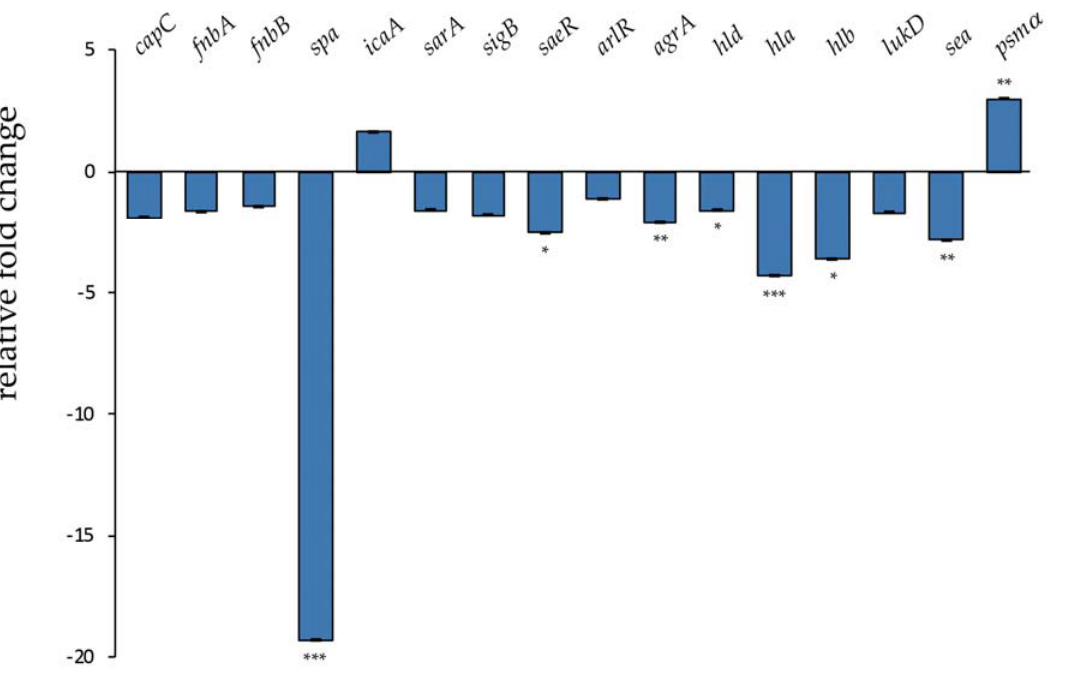
Figure 5. Transcriptional profiling of virulence factor genes in S. aureus ATCC 29213 after treatment with l ‐ NPDNJ determined by qRT ‐ PCR. Data were normalized to rpoB expression. Fold ‐ changes were calculated using treated versus untreated S. aureus cells. Asterisks indicate statistically significant differences between treated and untreated S. aureus cells (* p < 0.05, ** p < 0.01, *** p < 0.001). capC , capsule biosynthesis protein C; fnbA , fibronectin ‐ binding protein A; fnbB , fibronectin ‐ binding protein B; spa , surface protein A; icaA , intercellular adhesion protein A; sarA , staphylococcal accessory regulator A; sigB , RNA polymerase sigma factor B; saeR , response regulator SaeR; arlR , response regulator ArlR; agrA , accessory gene regulator A; hld , delta ‐ hemolysin; hla , alpha ‐ haemolysin; hlb , beta ‐ haemolysin; lukD , pore ‐ forming leucocidin; sea , staphylococcal enterotoxin A; psm , alpha phenol ‐ soluble modulin.